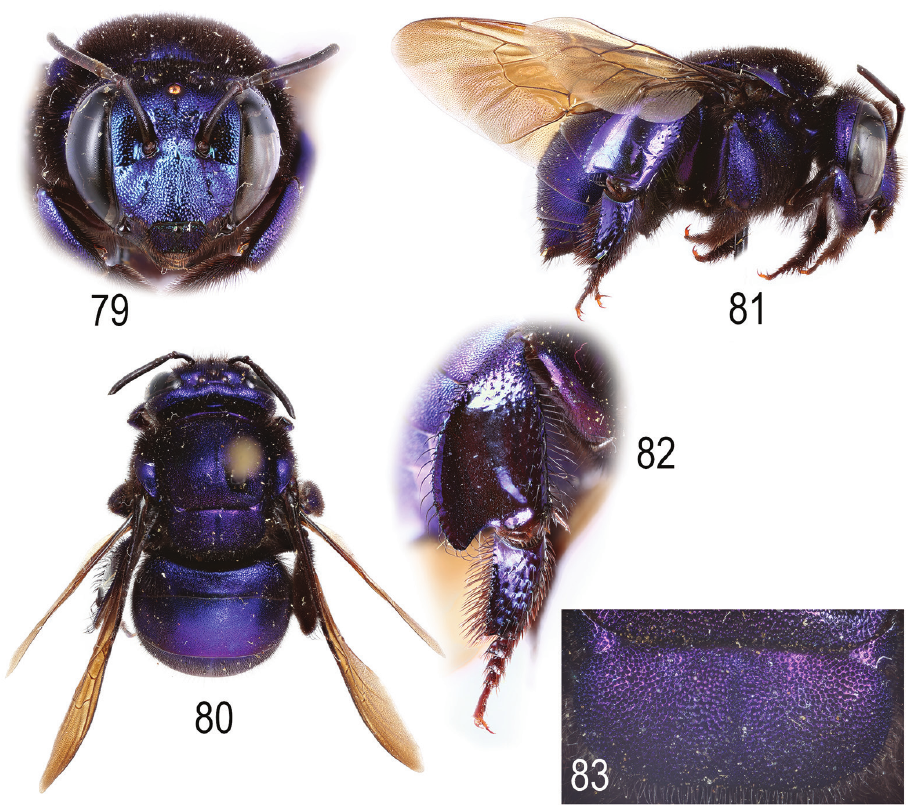
Figures 79–83. Female paratype of E. simillima (Mexico: Maguarichi, KUNHM-ENT 1091973). 79 Facial view 80 Dorsal habitus 81 Lateral habitus 82 Outer view of hind leg 83 Dorsal view of mes-